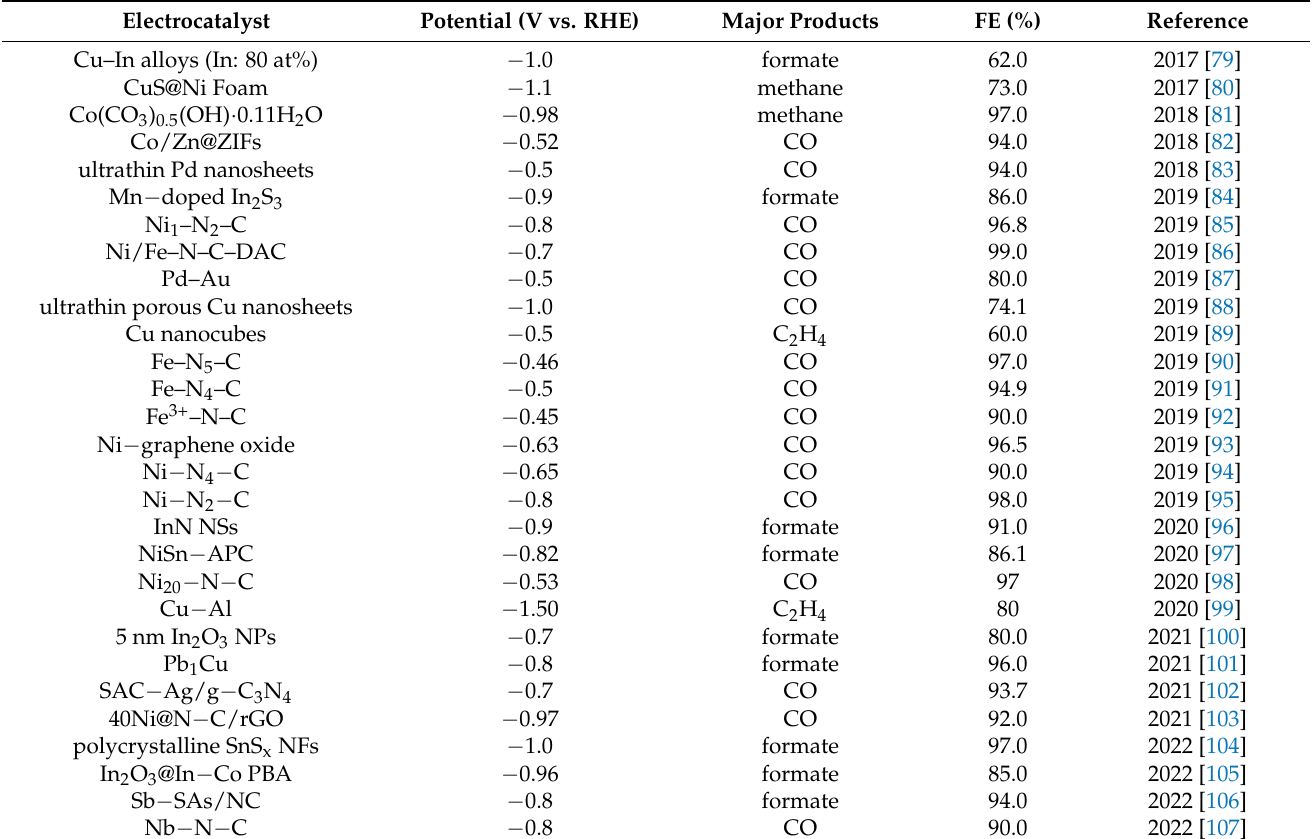
Table 2. Summary of the performance of typical electrocatalysts for electrocatalytic CO 2 reduction.